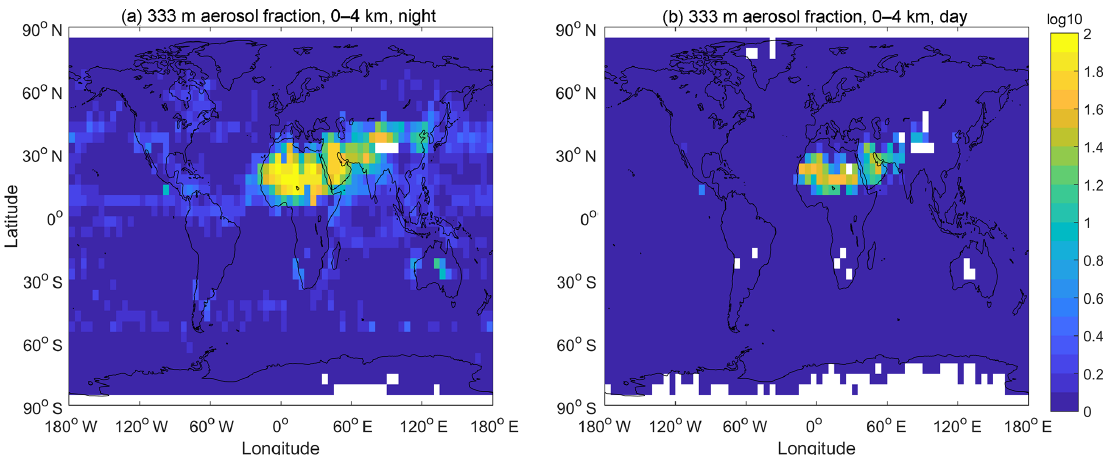
Figure 24. Spatial distribution of the fractional occurrence of the 333m aerosol layers out of all layers detected at 333m resolution between 0 and 4km in 2008 for (a) nighttime and (b) daytime data.